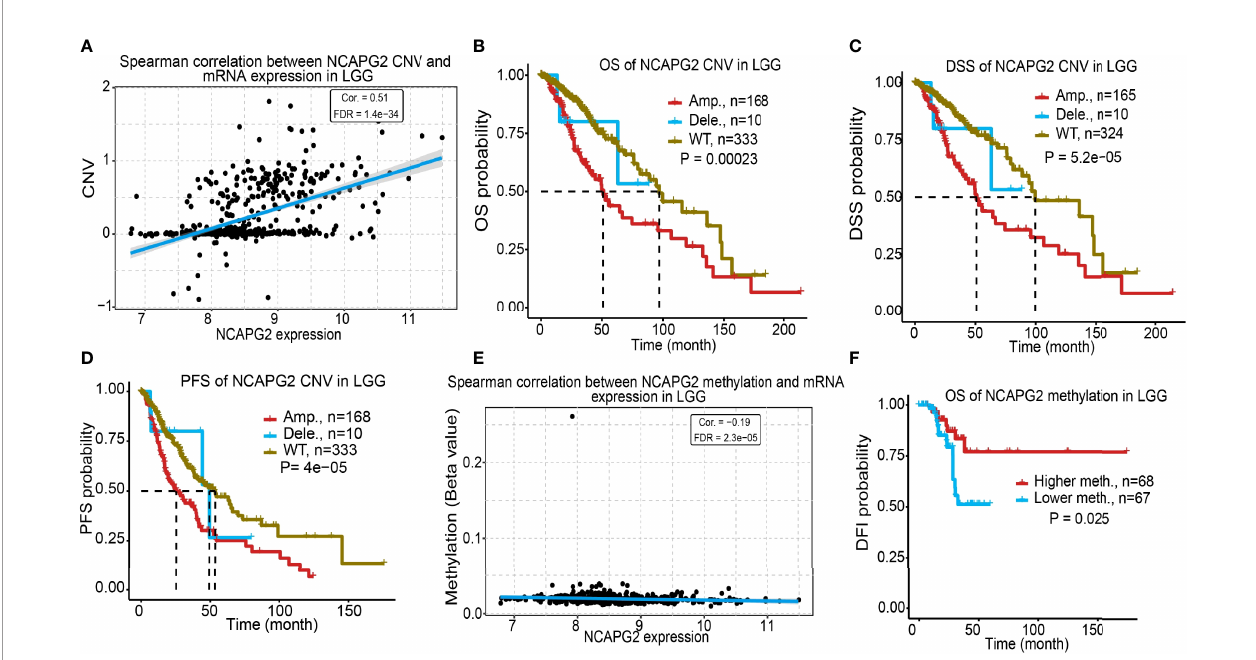
FIGURE 7 | Analysis of correlation between CNV, DNA methylation and NCAPG2 expression in LGG. (A) Analysis of correlation between CNV and NCAPG2 expression in LGG. (B – D) CNV of NCAPG2 was signi fi cantly correlated to OS, DSS and PFS in LGG. (E) Analysis of correlation between DNA methylation and NCAPG2 expression in LGG. (F) DNA methylation of NCAPG2 was signi fi cantly correlated to OS in